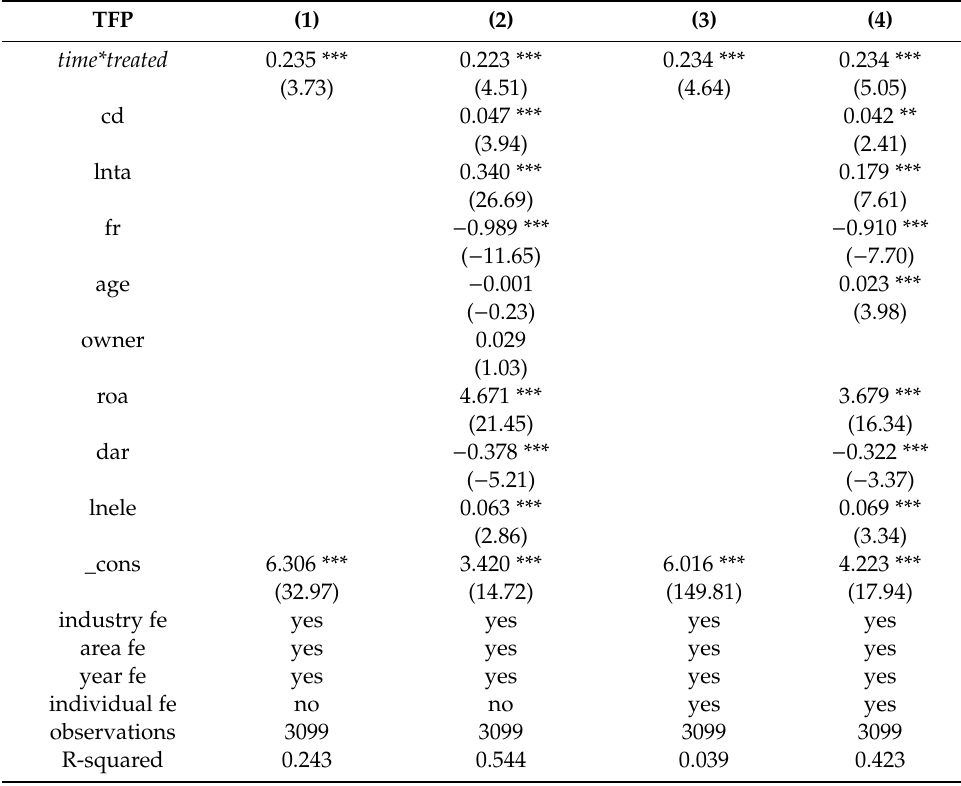
Table 2. Baseline estimations e ff ect of SO 2 emissions trading polit (ETP) on